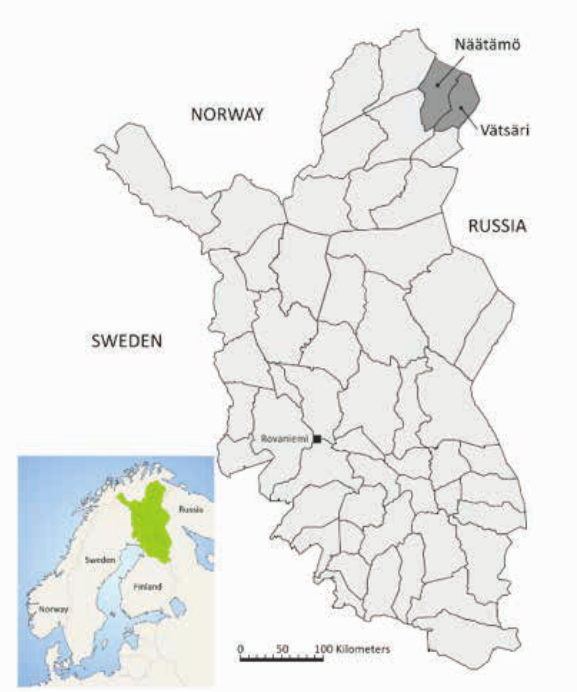
Figure 1: Location of the two contemporary Skolt Sami reindeer herding cooperatives, Näätämö and Vätsäri, in the Sevettijärvi area, in the Reindeer Herding District of Finland. The original living grounds of the Skolt Sami were located for the most part in areas that belong today to Russia and for minor parts to areas of today’s Norway and